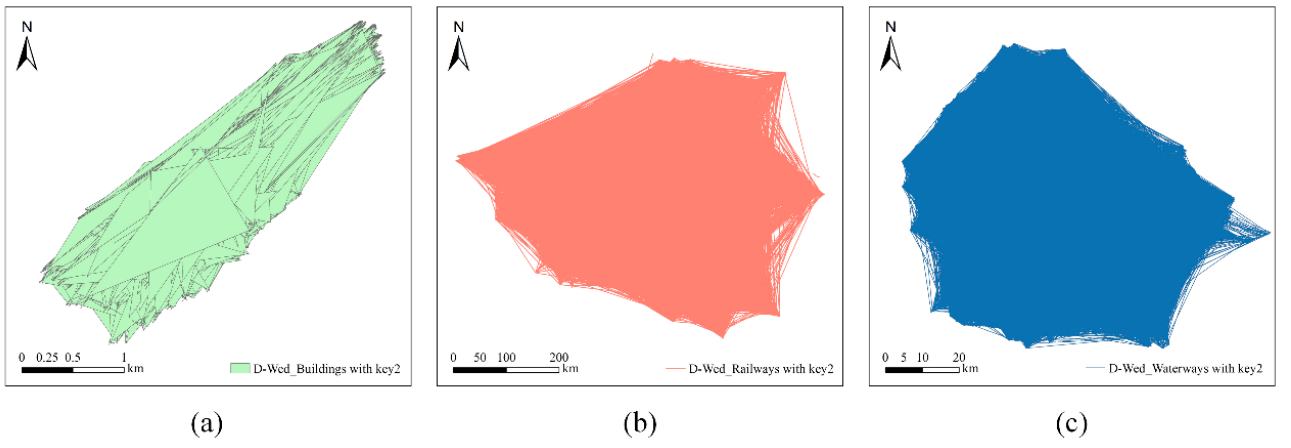
and 𝑘 . (cid:2869) (cid:2870)